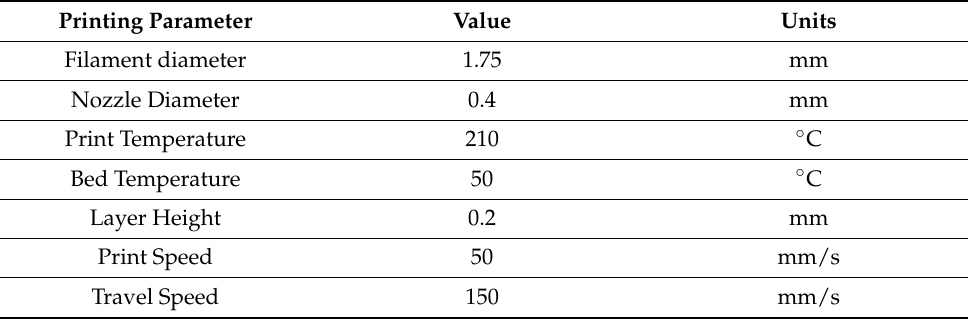
Table 2. Printing Parameters of 3D